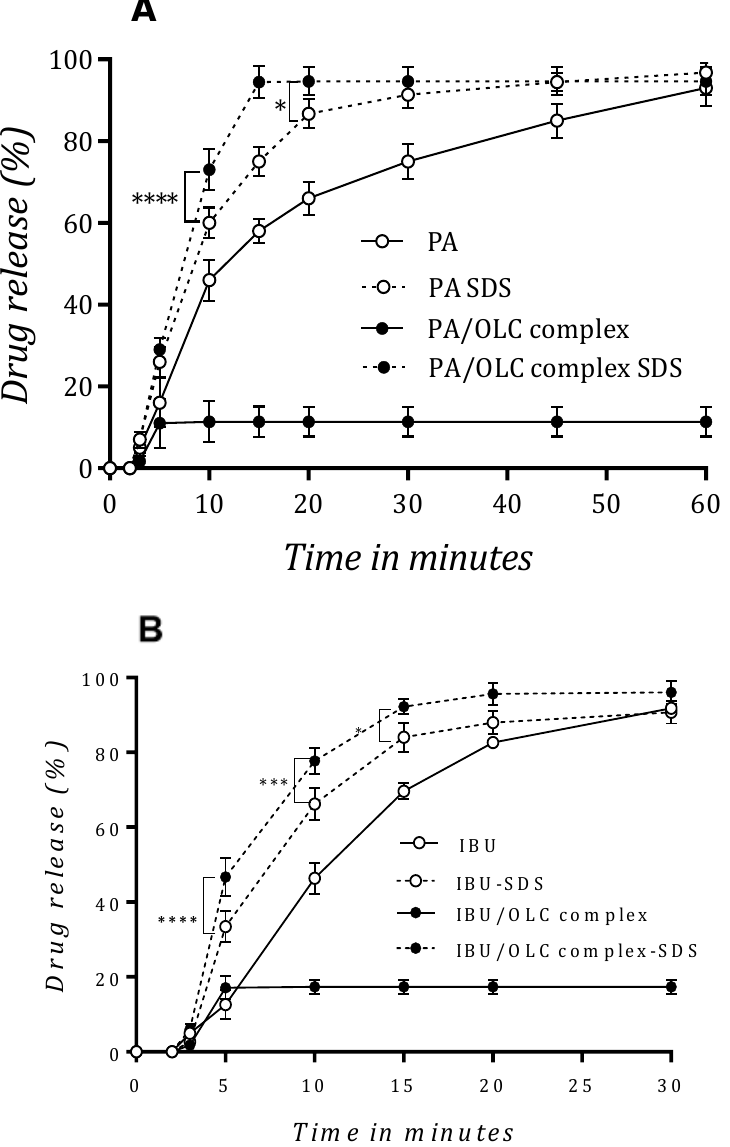
Figure 7. ( A ): Dissolution profiles of paracetamol (PA) and paracetamol-loaded carbon onion (PA / OLC complex) determined at pH 5.8. Curves PA-SDS and PA / OLC complex-SDS represent dissolution profiles determined in media containing 1% SDS. ( B ): Dissolution profiles of ibuprofen (IBU) and ibuprofen-loaded carbon onion (IBU / OLC complex) determined at pH 7.2. Curves IBU-SDS and IBU / OLC complex-SDS represent dissolution profiles determined in media containing 1% SDS. Statistically significant differences are noted for P < 0.05 (* P < 0.05; *** P < 0.001; **** P < 0.0001, two-way ANOVA and Bonferroni’s multiple comparison test). Results are the mean of triplicate experiments ± SD.